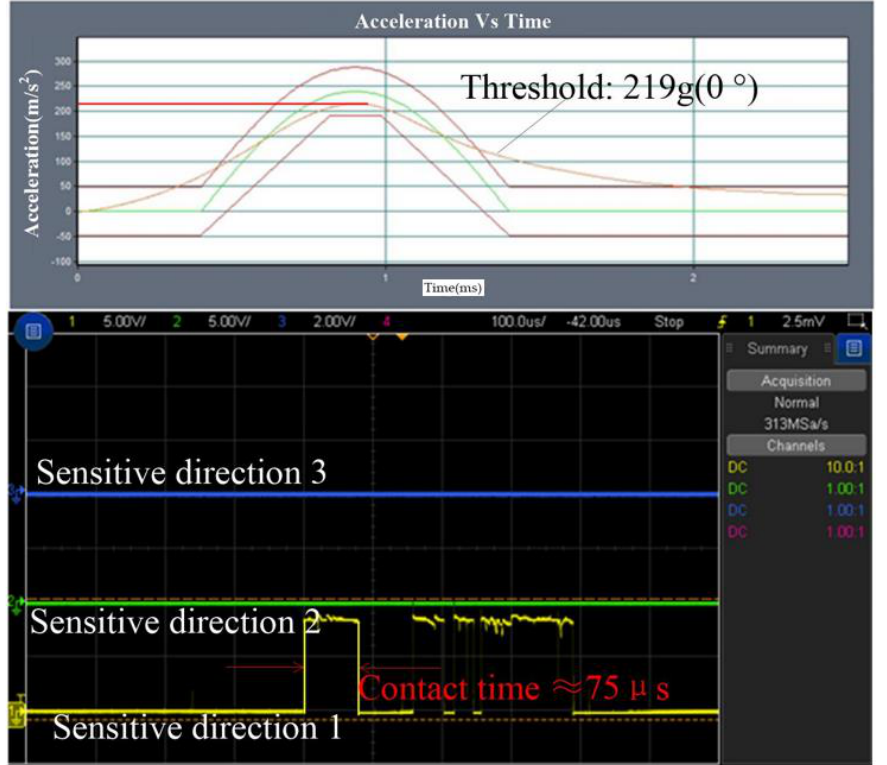
Figure 14. The tested threshold in one of the sensitive directions. The following conclusions can be drawn by testing the threshold values of the three- axis inertial switch in multiple